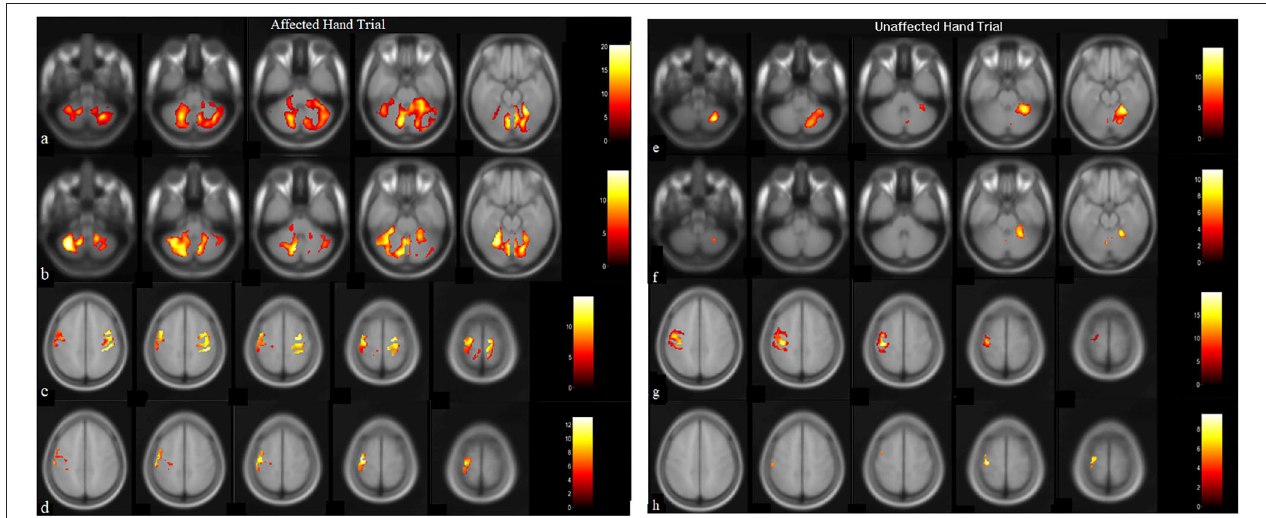
FIGURE 2 | BOLD images for wrist extension task with voxel level threshold p < 0.05 (FWE-corrected) and cluster size threshold of 10 voxels. Thirty-one ascending transversal slices, repetition time (TR): 2,000ms, field of view (FOV): 230 × 230 × 155mm, Flip-angle: 90 degrees, voxel size: 1.8 × 1.8 × 5mm and echo time (TE) = 30ms. Presentation on MR compatible 20” LCD monitor (Esys in vivo eprime 1.1) with projection on mirror attached to head coil where image-of-hand notifies the active-block and cross on image-of-hand represents the rest-block. Data-analysis (in SPM12) included realignment by aligning images to mean-image, co-registration using T1-image, normalized, and smoothing with 8 × 8 × 8 Full Width at Half-Maximum (FWHM) filter on pre and post-BOLD images. Talairach-client was used to correlate MNI-coordinates with gray and white matter. (a,c) are pre-robotic training images, (b,d) are post-robotic training images during affected-hand trial, (e,g) are pre-robotic training images and, (f,h) are post-robotic training images of masked regions cerebellum ( − 52:8: − 20 slices) and sensorimotorcortex (48:6:72 slices) during the unaffected-hand trial ( p < 0.05).